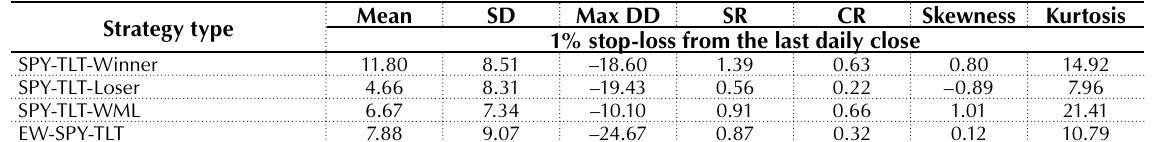
Table 3. Summary statistics of SPY-TLT equal weight portfolio with daily stop loss January 1, 2004